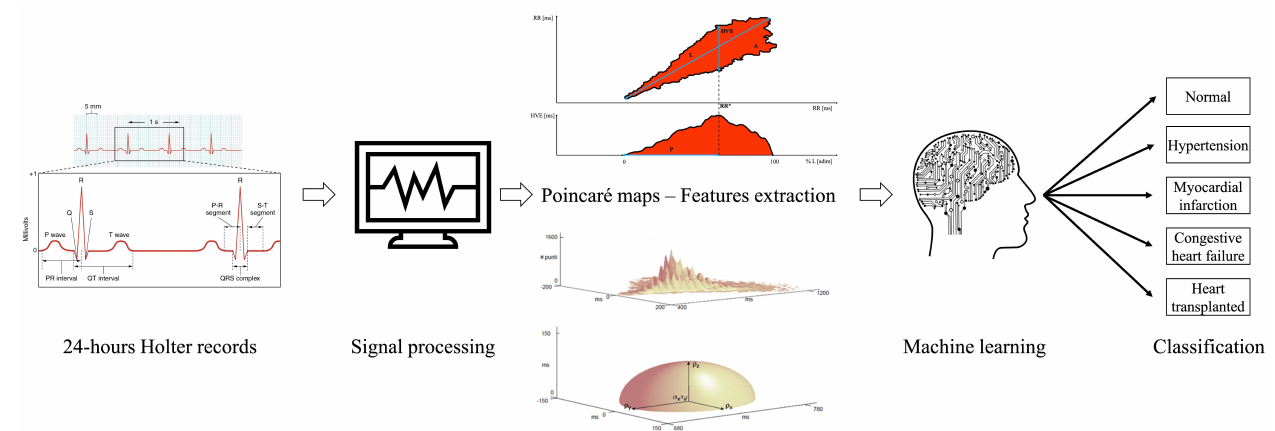
Figure 1. Study workflow. ECG recordings are processed to achieve Poincar é maps from which specific features are extracted. Finally, ML strategies are fed (using these features) to demonstrate that the selected algorithms are capable to suitably classify the group to which each Holter record belongs to. Attributions: 2022 electrocardiogram from Wikimedia and ecg machine by ProSymbols from the Noun